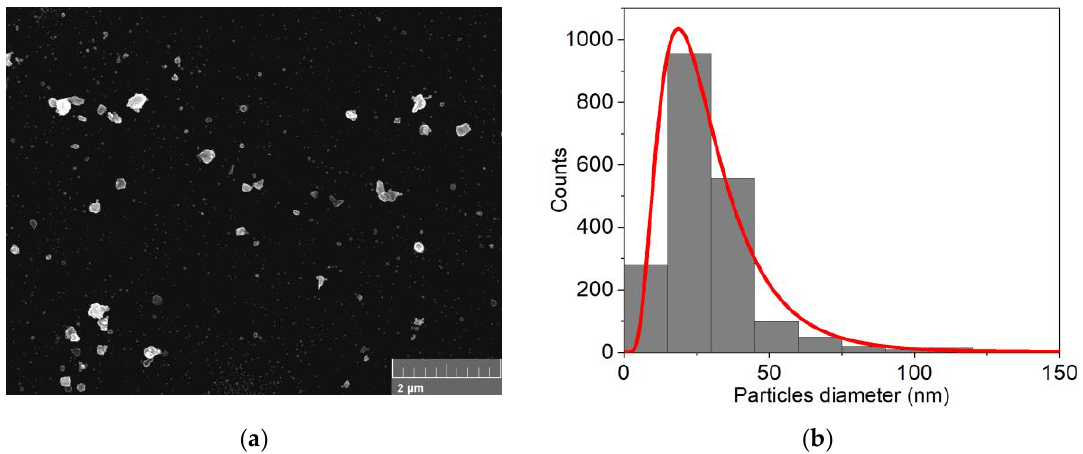
Figure 5. ( a ) SEM analysis of 30 nmol of CdSe deposited on n-Si with the alternating method (sample C); ( b ) particles distribution obtained from the SEM image.